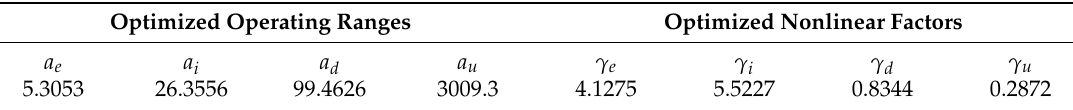
Figure 9. The step responses: ( blue ) the conventional PID controller; and ( red ) the proposed optimal fuzzy PID controller. Table 1. The eight optimized parameters.